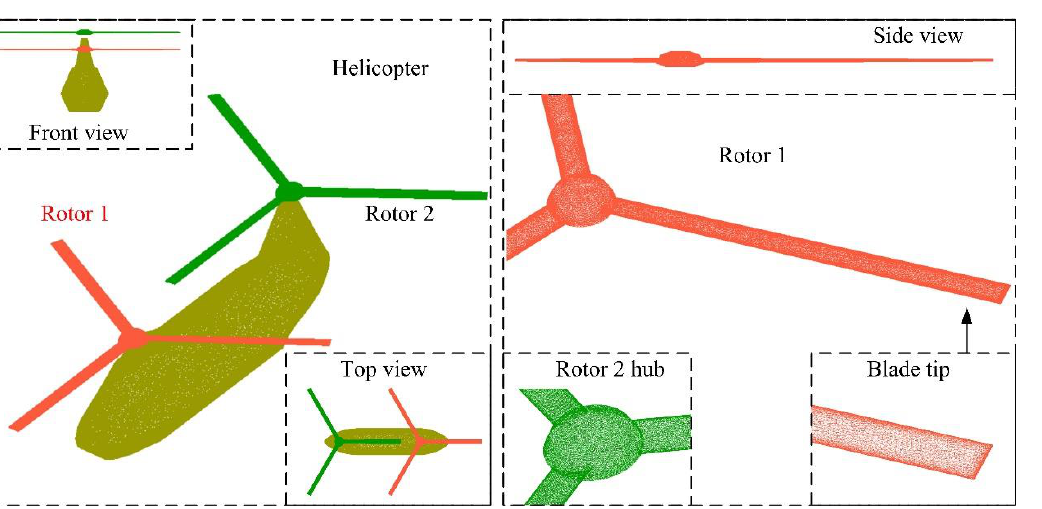
Figure 4. Model and size distribution of rotor 1.